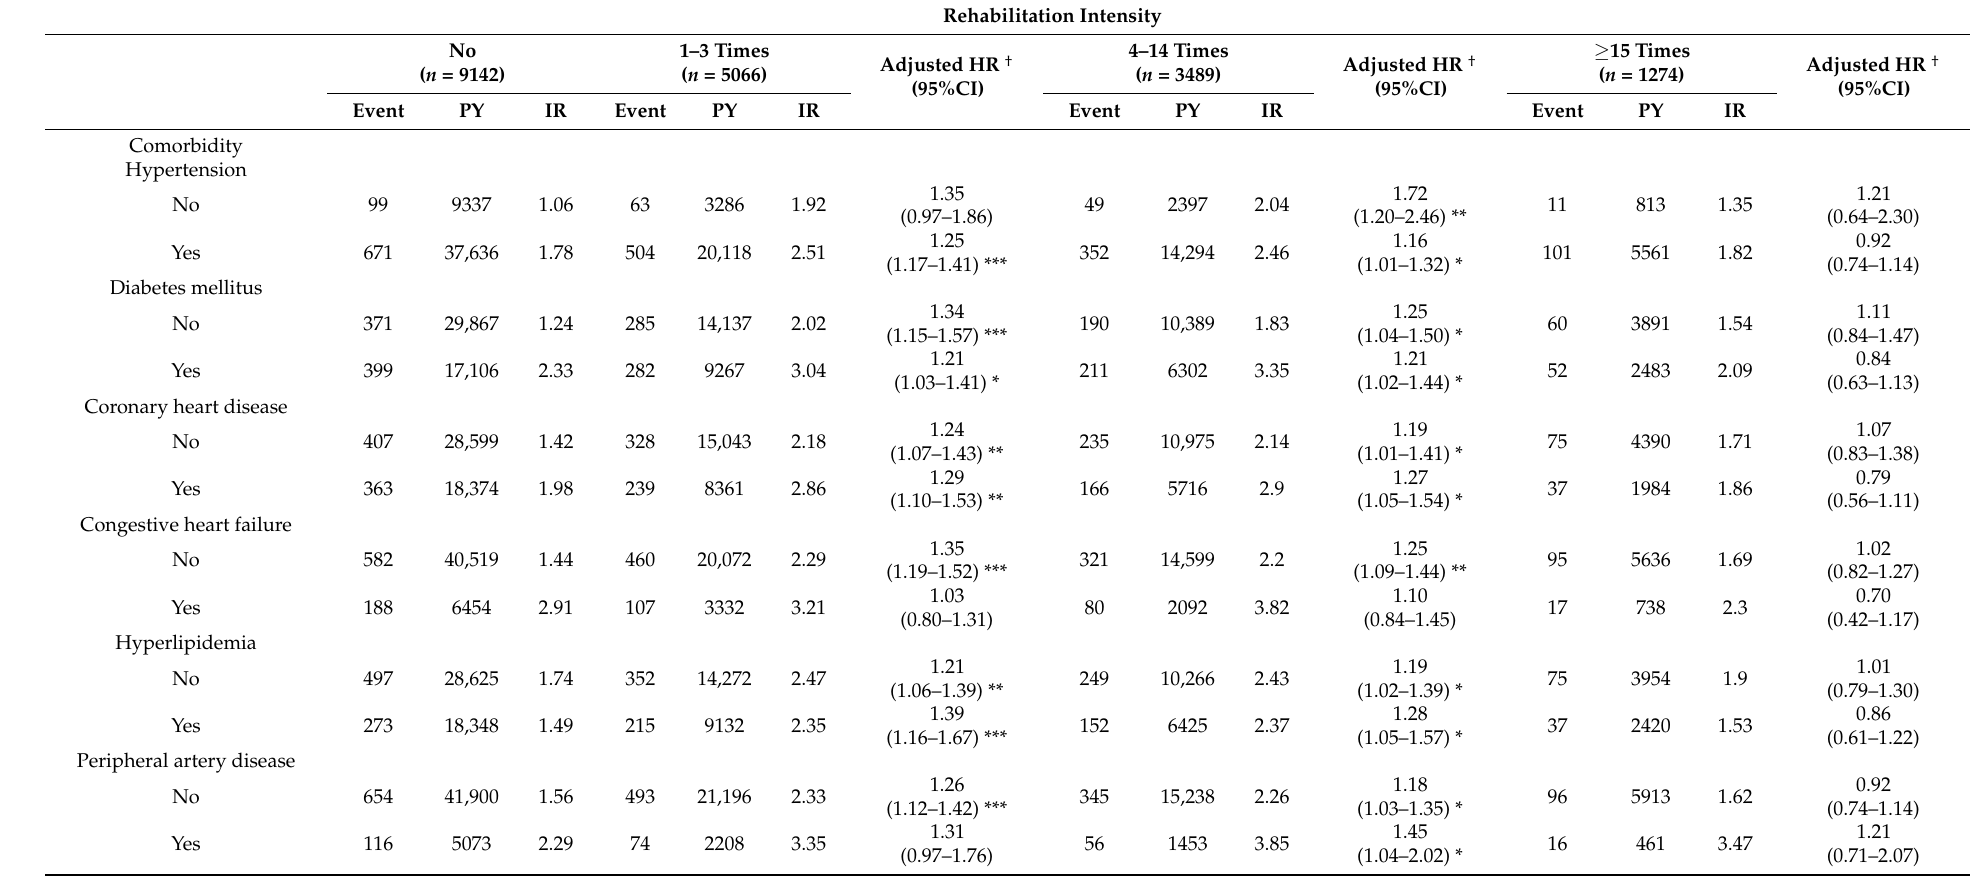
Table 3. Incidence rate and hazard ratio of pressure ulcer among four groups stratified by